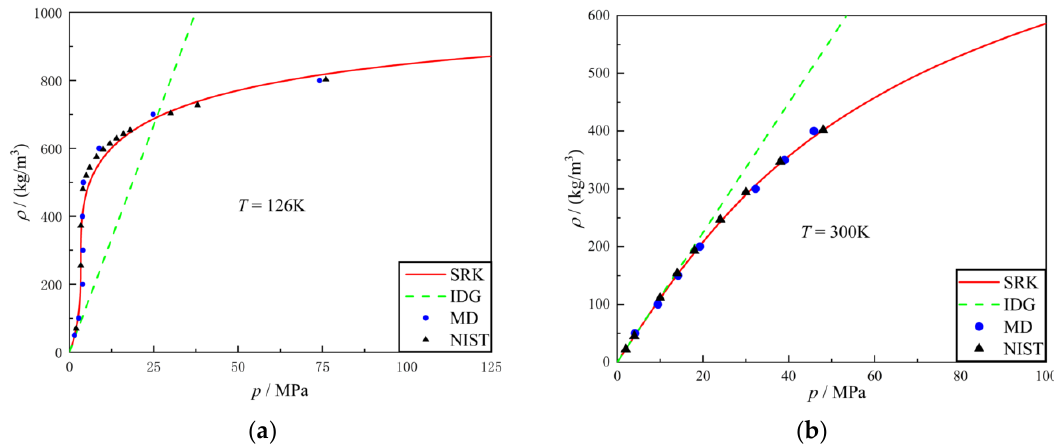
Figure 7. Results of molecular dynamics of nitrogen compared with SRK EOS, ideal gas EOS and NIST data at different temperatures: ( a ) T = 126 K; ( b ) T = 300 K.